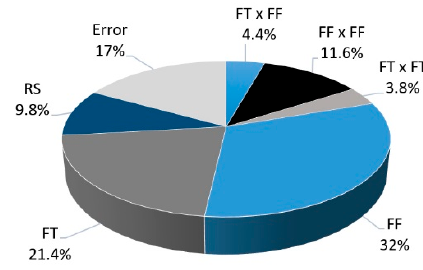
Figure 14. Relative contributions of the model factors to the response UTF.